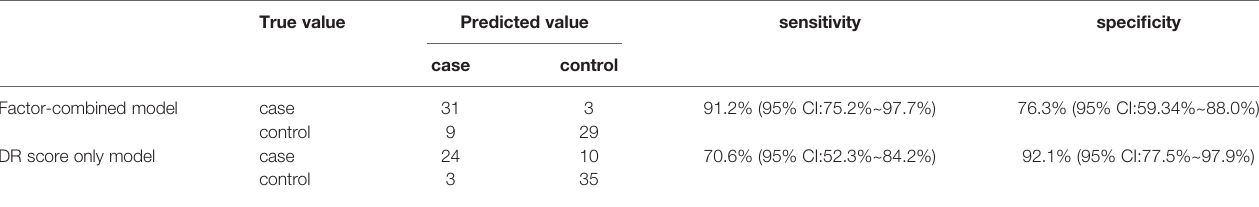
TABLE 4 | The classi fi cation results of the test sets for screening